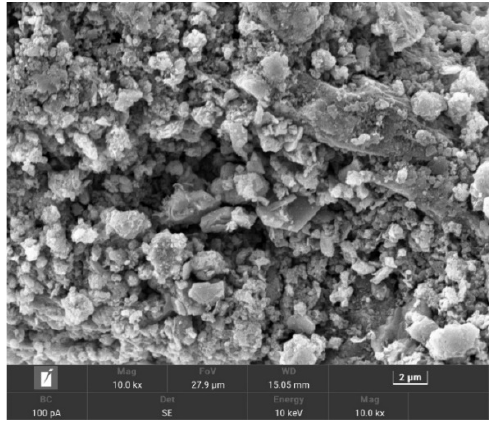
Figure 2. SEM of the zinc ‐ containing dust.